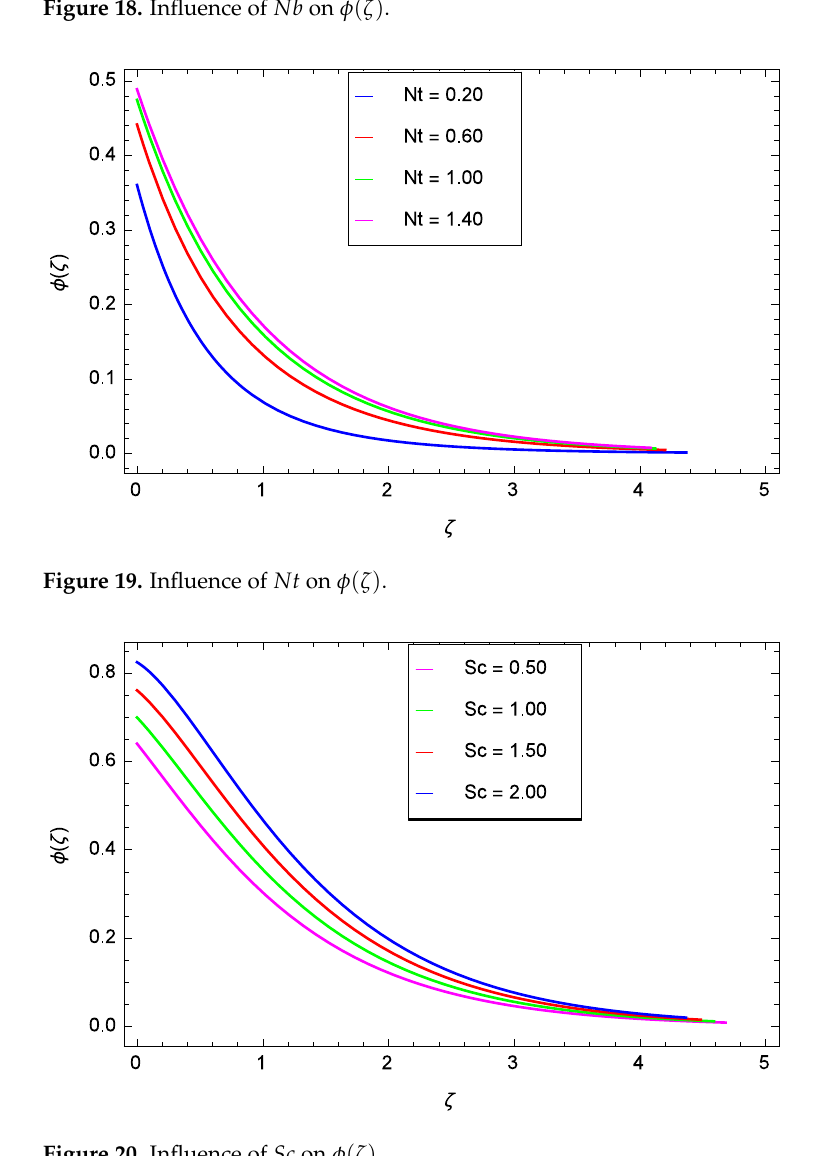
Figure 20. Influence of Sc on φ ( ζ )